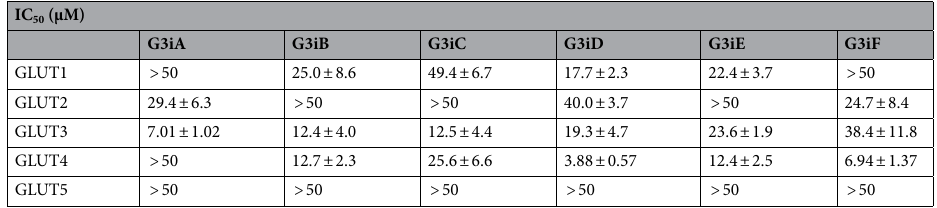
Table 2. GLUT3 inhibitor selectivity. IC 50 of G3iA-G3iF for transport inhibition of GLUT1-5 assayed in the hxt 0 yeast assay systems. Dose response curves for GLUT3 are in Fig. 2, those for GLUT1, GLUT2, and GLUT4 are in the Supplementary Fig. S6. The effect of GLUT3 inhibitors on GLUT5 is shown in Fig. 3D.